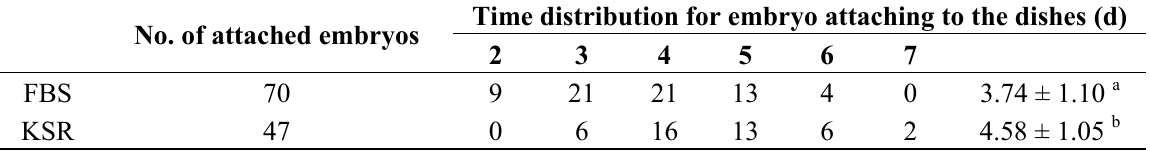
Table 1. The required time for embryo attachment in the different medium.